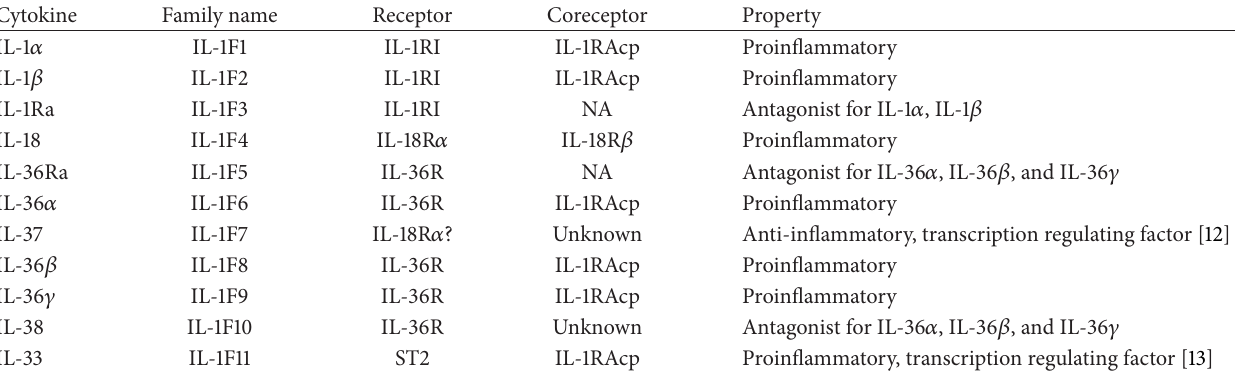
Table 1: IL-1 family members [10, 11].